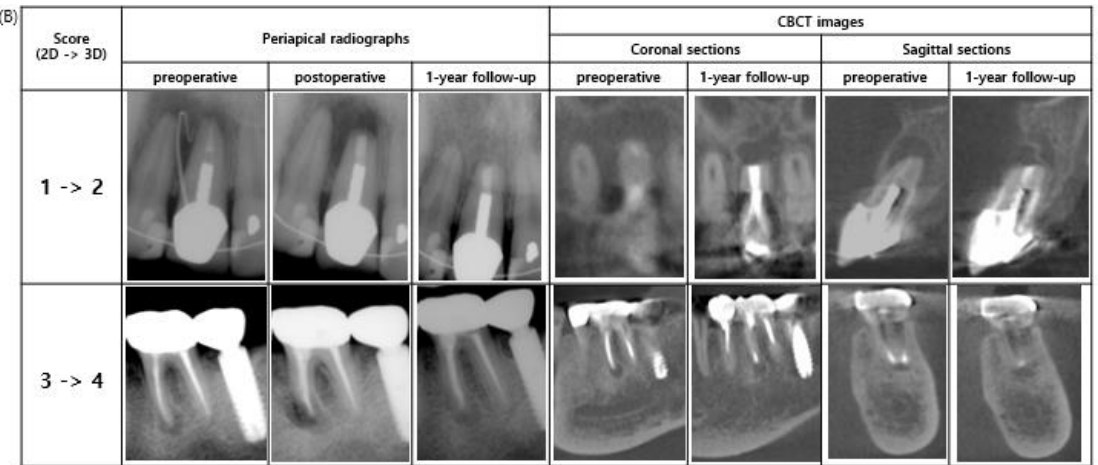
Figure 2. ( A ) Examples of agreement cases. The images in each row were scored 1, 2, 3 and 4 resulted from both 2D and 3D assessments. ( B ) Examples of disagreement cases. The images at the first row were scored 1 from 2D assessment, but scored 2 from 3D assessment. The images at the second row were scored 3 from 2D assessment, but 4 from 3D